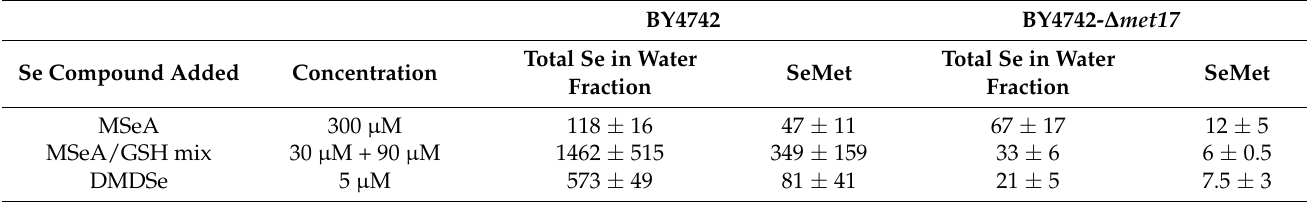
Table 4. Total Se and SeMet content ( µ g/g dry weight) in the water-soluble fraction of BY4742 or BY4742- ∆ met17 cells grown in SD + 100 µ M cysteine and incubated for 30 min in the presence of MSeA, MSeA/GSH mix, or DMDSe. Means and standard deviations were calculated from three replicate measurements of at least two independent experiments. BY4742 BY4742- ∆